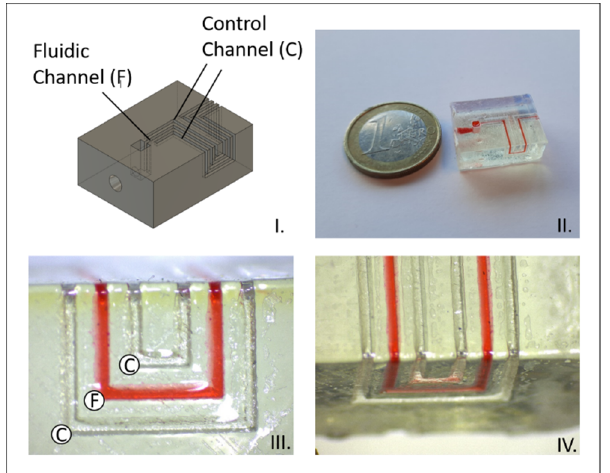
Figure 3. ( I. ) Rendering of a basic example of a testing chip with two crossings of a 270° angle. The control channels are flanking the fluid channel and turn red if they fill due to leakage. ( II. ) Resulting 3D-print carrying water colored with red food coloring. ( III. , IV. ) Close-up of the angle crossing with control channels (C) and the fluid carrying channel (F).